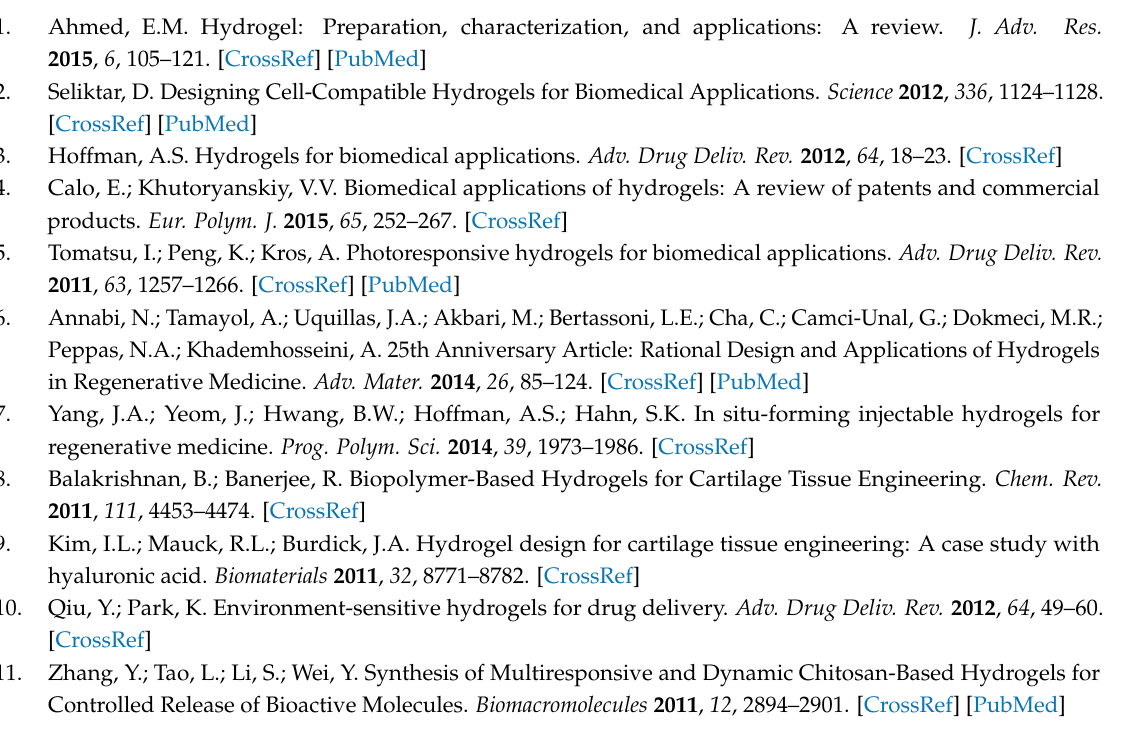
s1. Figure S1. SEM images of PAS gels with different Al 2 O 3 content. Figure S2. Illustration of the dissolution of neat poly(AA- co -AMPS) gels without Al 2 O 3 NPs. Figure S3. Illustration of mechanical properties of BIS cross-linked hydrogel and neat poly(AA- co -AMPS) hydrogel. Figure S4. Stress–strain curves of original and healed PAS